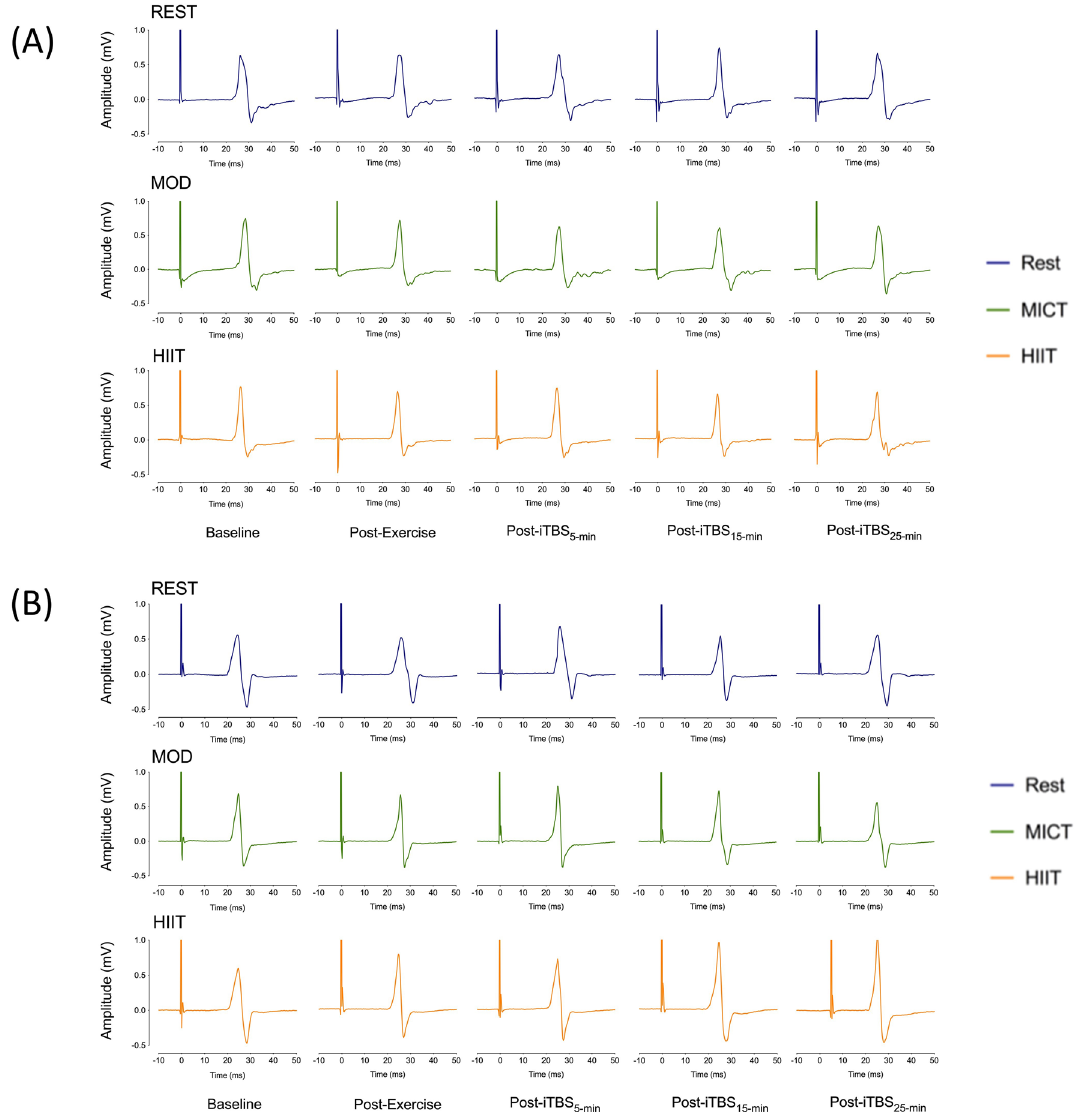
Figure 3. Examples of raw single motor-evoked potentials (MEPs) from one HD participant ( A ) and one control participant ( B ) during rest, moderate-intensity continuous training (MICT) and high-intensity interval training (HIIT). These MEPs were selected to illustrate the changes in cortico-motor excitability from baseline to post intermittent theta burst stimulation (iTBS) in the HIIT condition for control participants, but not HD